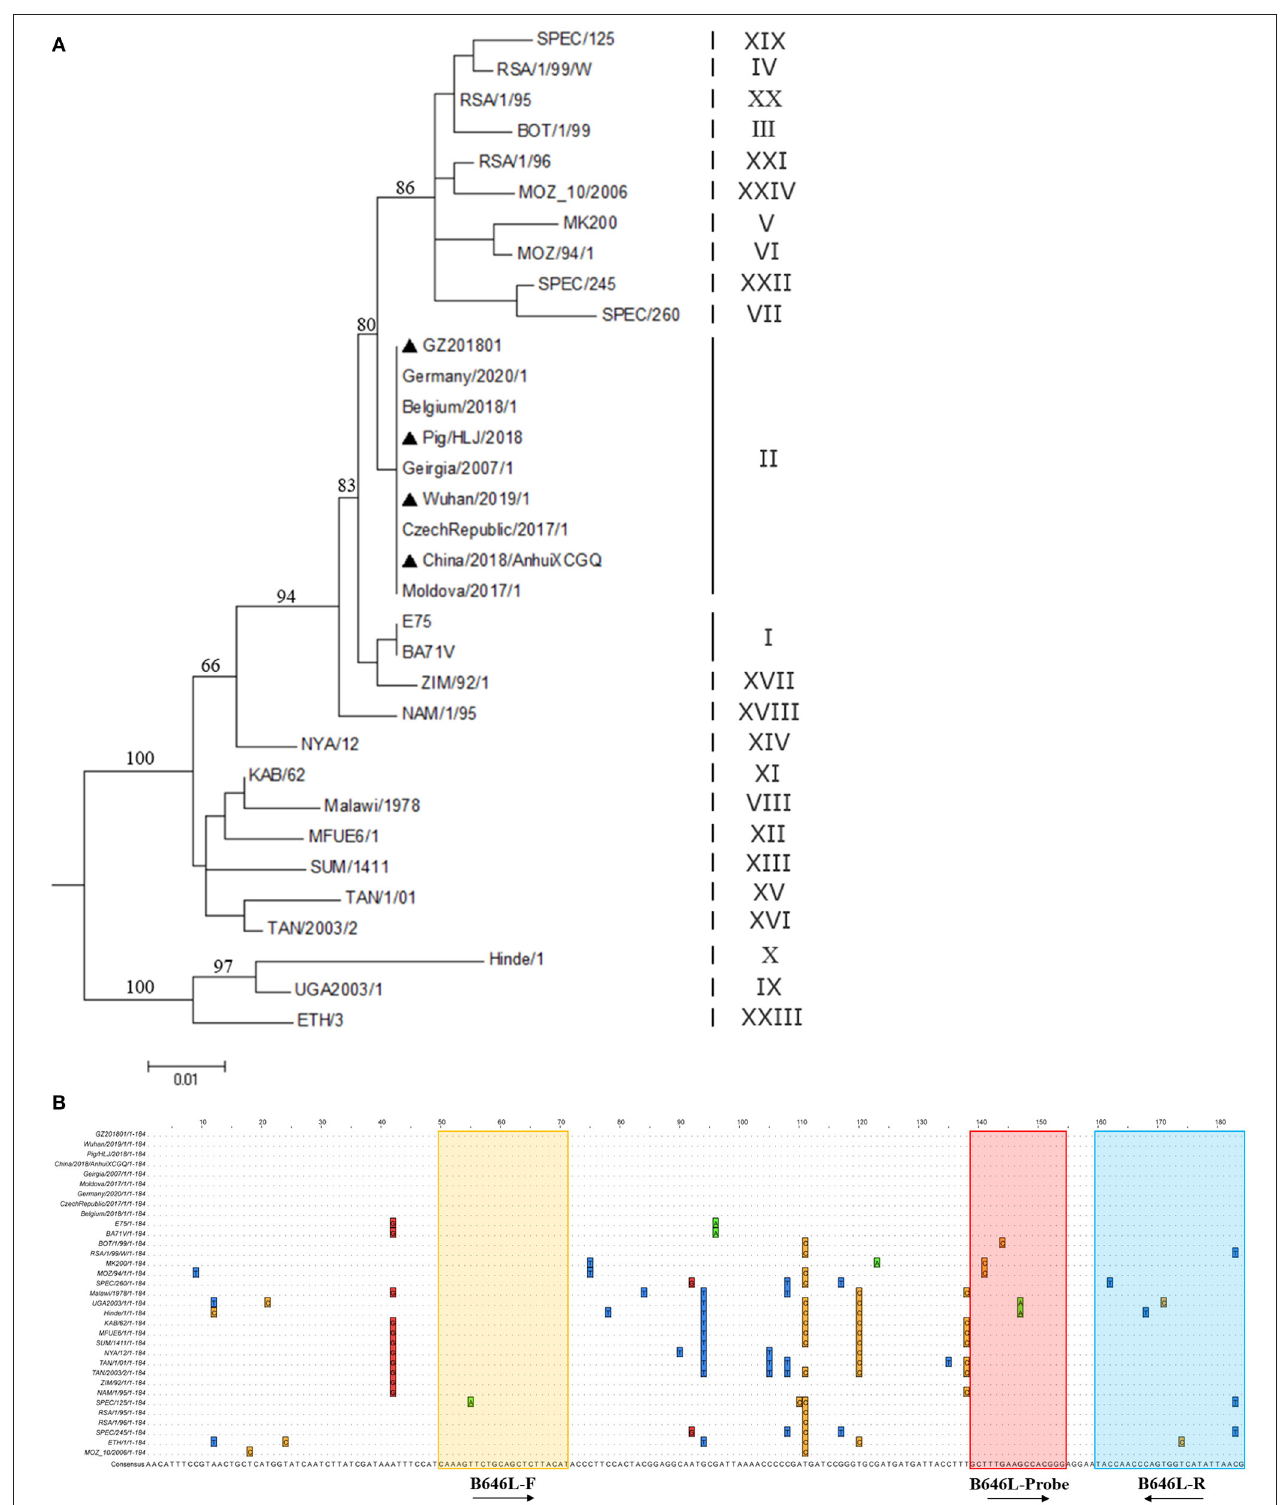
FIGURE 1 | Genetic evolution of different ASFV genotypes and comparison of B646L sequences. (A) According to the B646L sequence of the 24 ASFV genotypes, the genetic evolution tree was constructed using the MEGA7.0 software. The strains marked by N are the popular strains in China. (B) The B646L sequences in 24 ASFV genotypes were analyzed via Clustal W using the Megalig software (DNASTAR, Inc.).